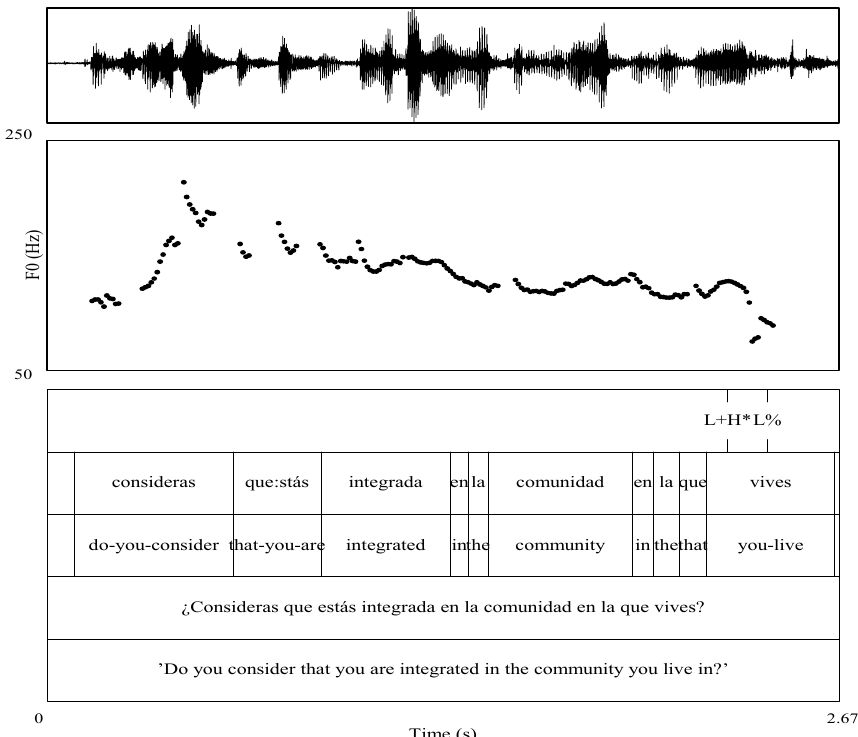
Figure 1. F0 contour of an absolute interrogative statement in Basque Spanish by a male L1 Spanish / L2 Basque speaker from San Sebastian.